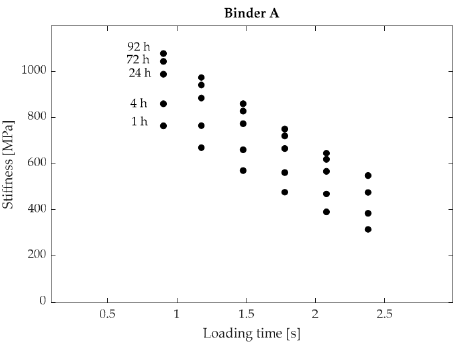
Figure 2. Creep stiffness as a function of loading time at different conditioning times (binder A at − 24 ◦